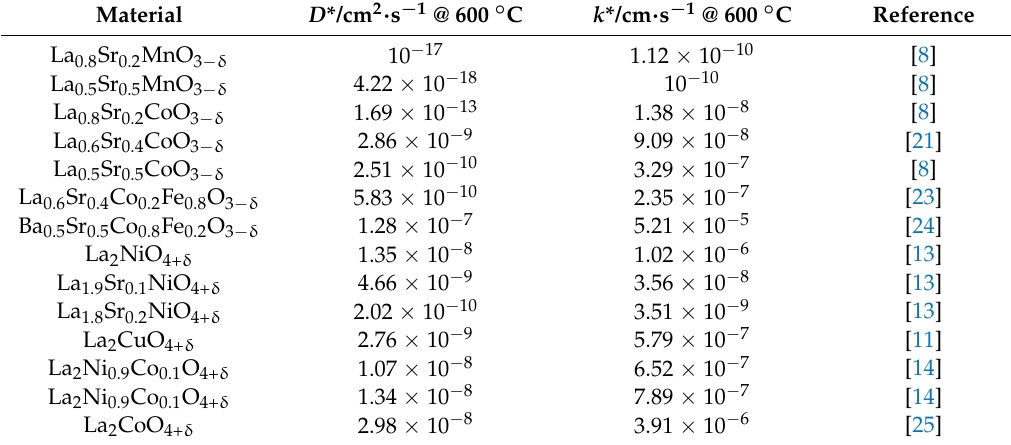
Table 1. Oxygen self-diffusion ( D *) and surface exchange coefficients ( k *) for solid oxide fuel cells (SOFC) cathode